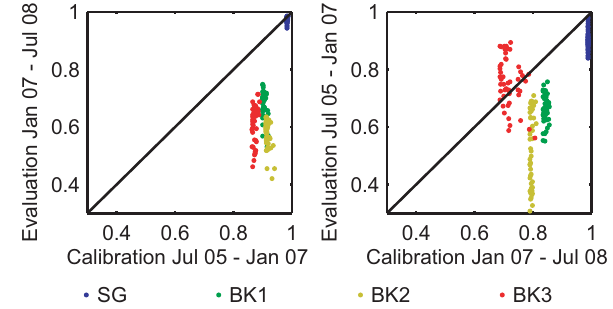
Fig. 4. Model performance of four models for the calibration versus the evaluation periods. Here, R is used as a performance